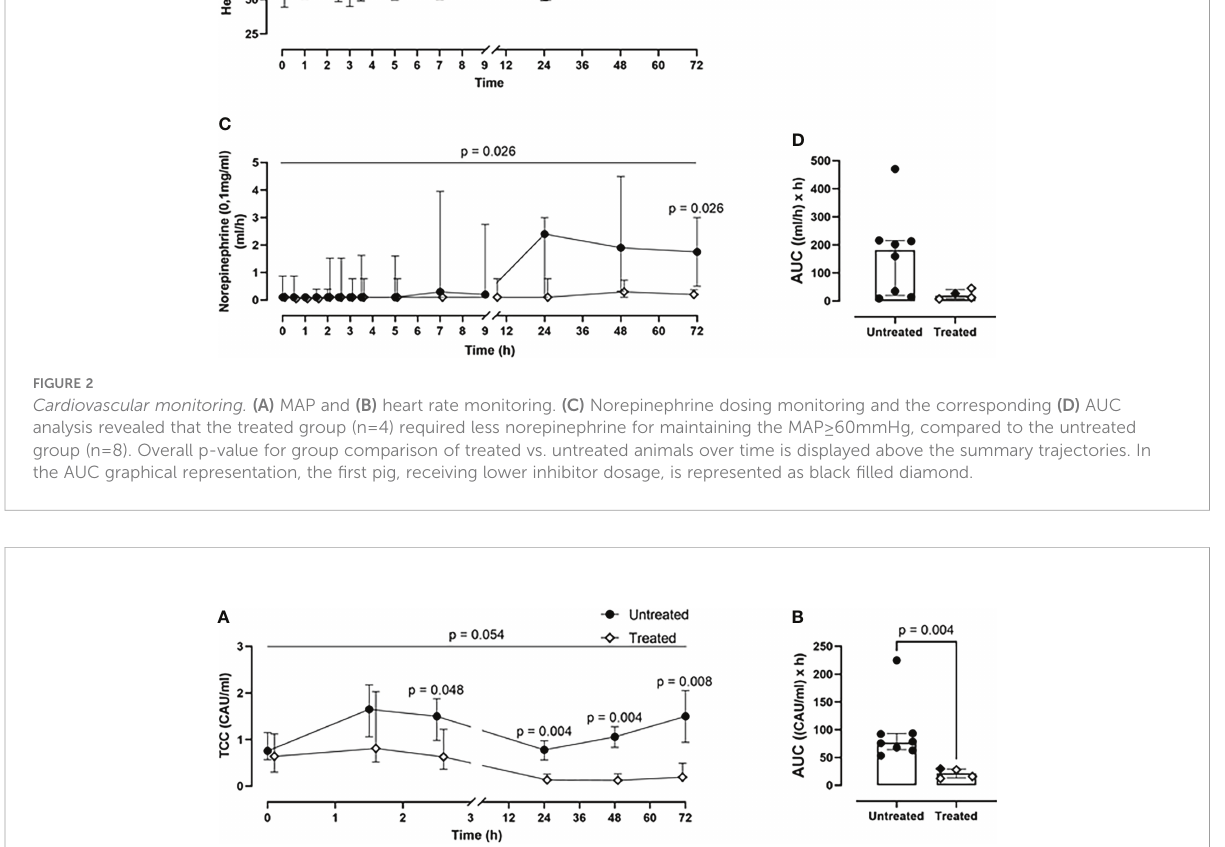
FIGURE 3 Blood TCC measurements. (A) TCC formation 2.5-, 24-, 48-, and 72-h after trauma was reduced in the treated group (n=4), compared to the untreated group (n=8). (B) Area under the curve analysis showed a statistically signi fi cant reduction of TCC in the treated group. Overall p-value for group comparison of treated vs. untreated animals over time is displayed above the summary trajectories. In the AUC graphical representation, the fi rst pig, receiving lower inhibitor dosage, is represented as black fi lled